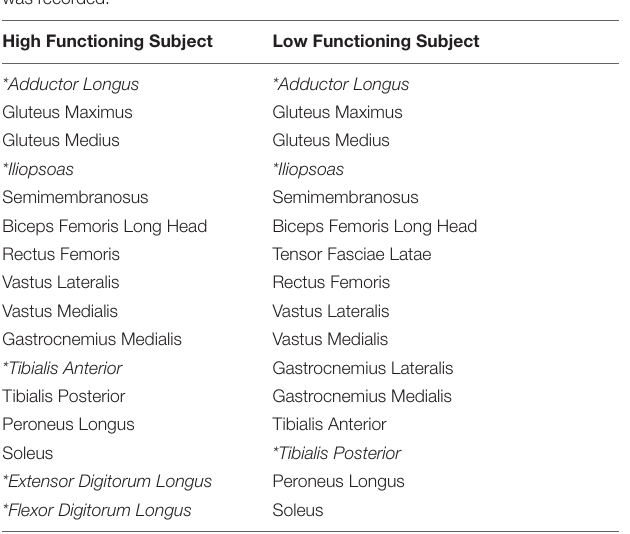
TABLE 2 | Muscle groups from which a surface or fine-wire (*) EMG signal was